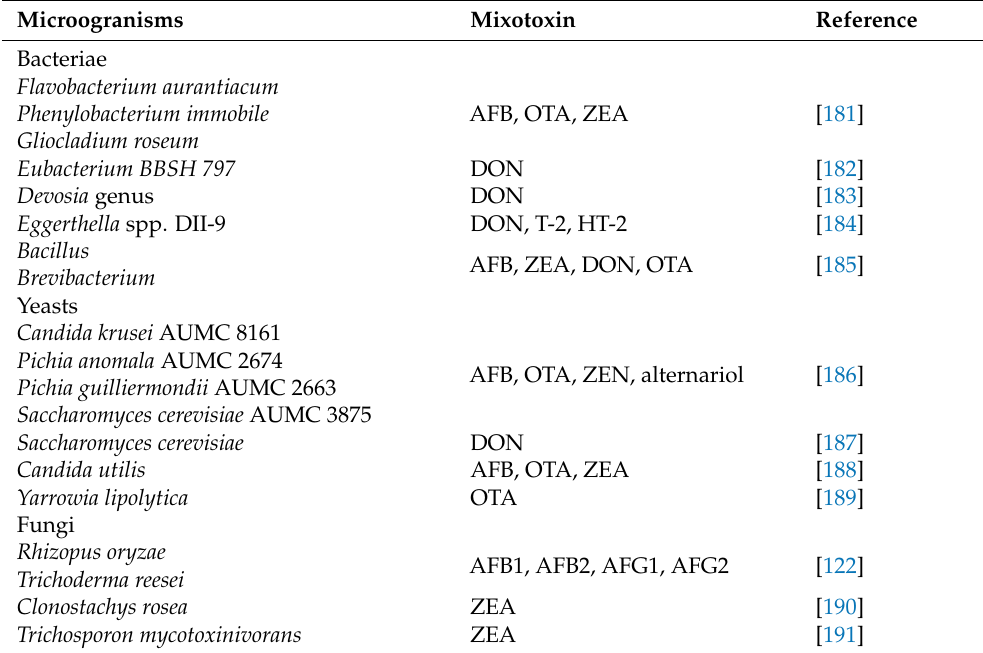
Table 3. Microorganisms capable of detoxifying